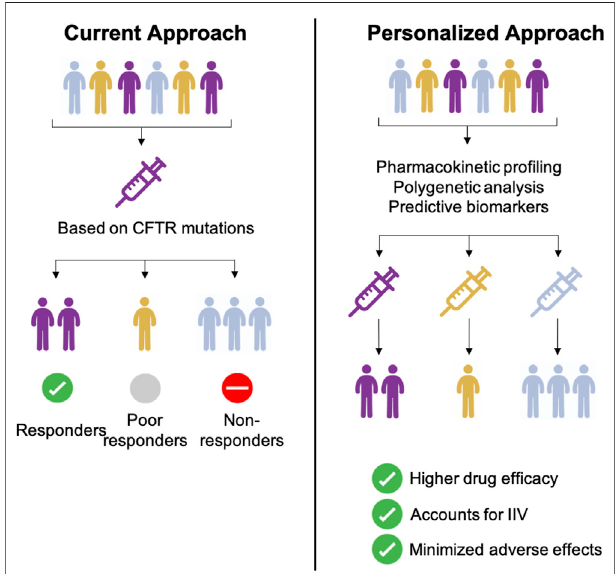
FIGURE 4 | Comparison between current and personalized therapeutic approaches for CF